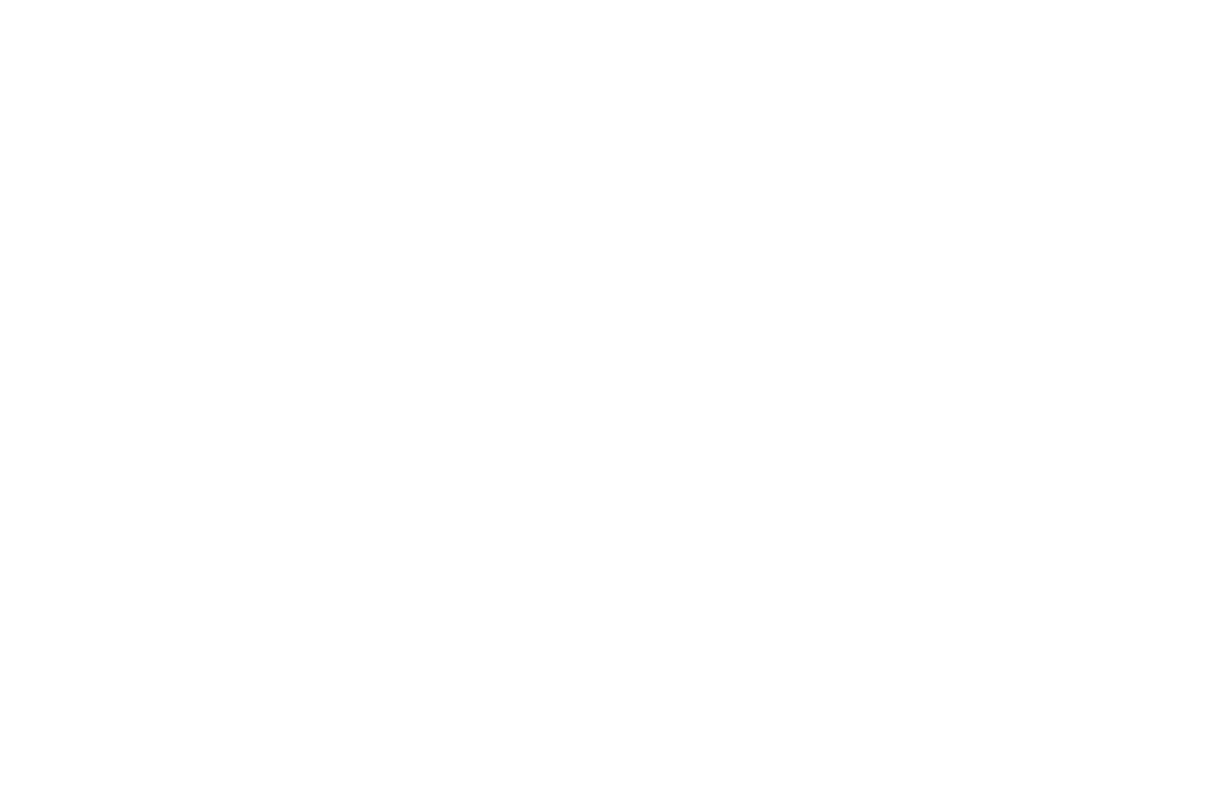
Figure 12. Potential and less potential groundwater recharge